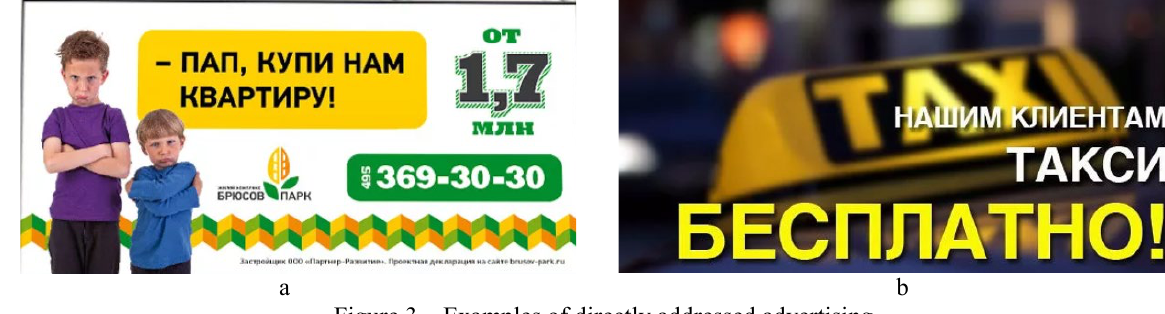
Figure 3 – Examples of directly addressed